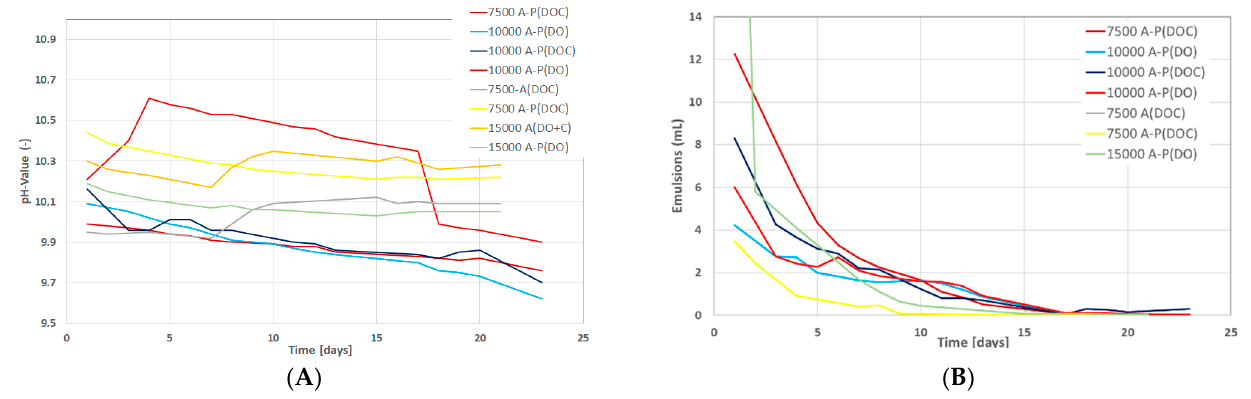
Figure 6. Change in pH value and emulsion volume over time for the phase behavior tests at different concentrations of chemicals. ( A ) Change in chemical formulation over number of days. ( B ) Change in produced emulsion volume over number of days. A refers to alkali concentration in ppm, P stands for polymer concentration of 1850 ppm, (DOC) represents dead oil with cyclohexane, and (DO) represents dead oil.